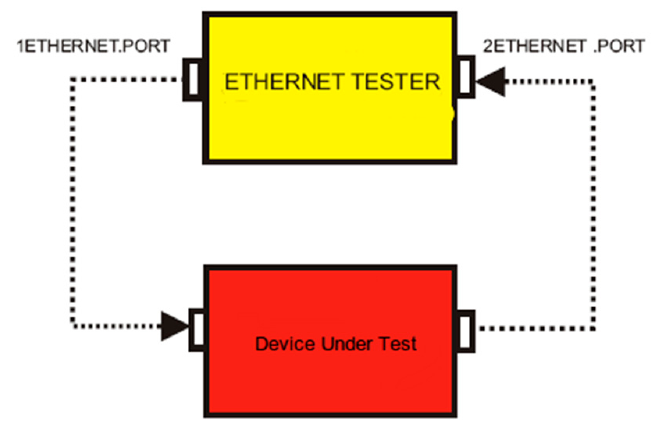
Figure 2. Dual-port testing of a single network element.